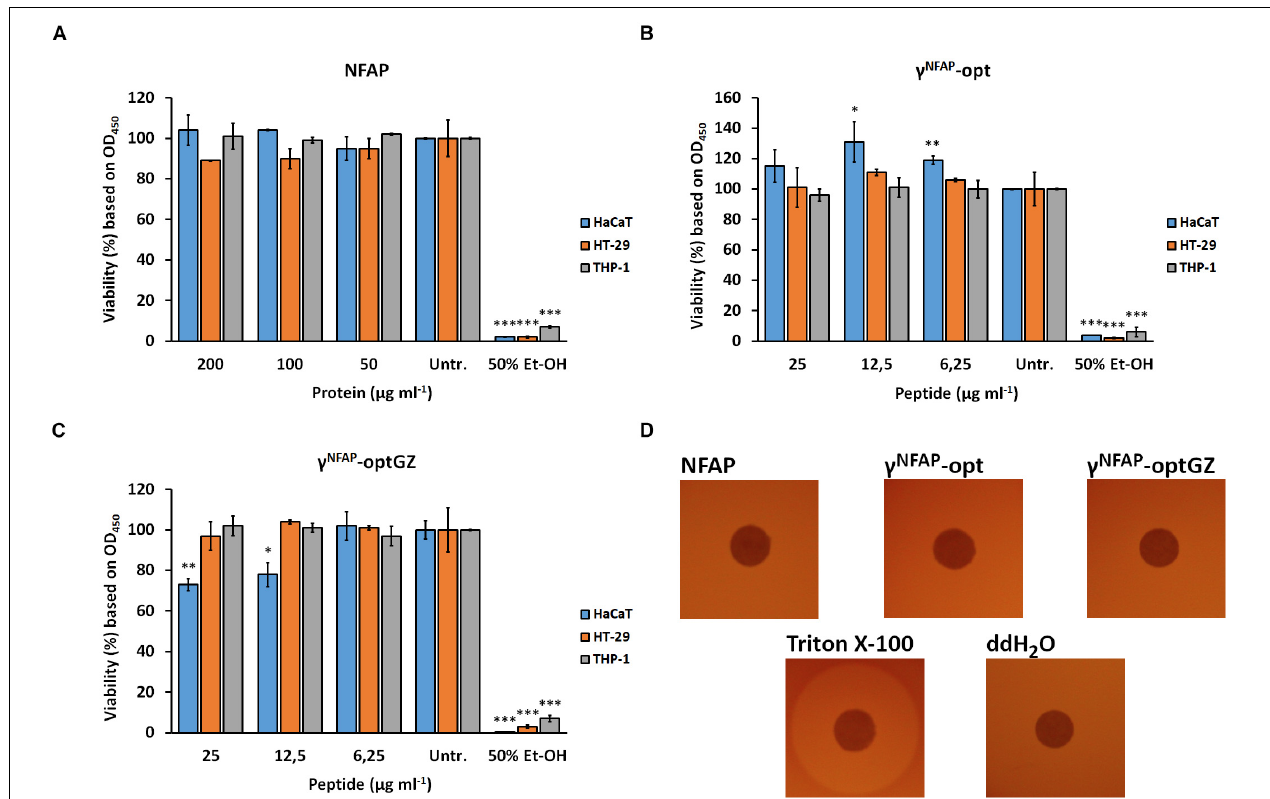
FIGURE 3 | Viability of keratinocytes (HaCaT), colonic epithelial cells (HT-29), and monocytes (THP-1) after treatment with different concentrations of (A) Neosartorya fischeri antifungal protein (NFAP), (B) γ NFAP -opt, or (C) γ NFAP -optGZ peptides for 24 h and with 50% (v/v) ethanol (Et-OH) for 10 min in comparison with the untreated control (Untr.). (D) Hemolytic activity of 40 µ g NFAP, 25 µ g γ NFAP -opt and γ NFAP -optGZ peptides on Columbia blood agar plates after incubation for 24 h at 37 ◦ C. Triton X-100 [20% (v/v)] and ddH 2 O were used as the positive and negative controls, respectively. Significant differences from two-sample t -test in (A – C) are indicated with ∗ ( P ≤ 0.05), ∗∗ (0.0001 < P ≤ 0.005), and ∗∗∗ ( P ≤ 0.0001) in comparison of each treatment with the untreated control